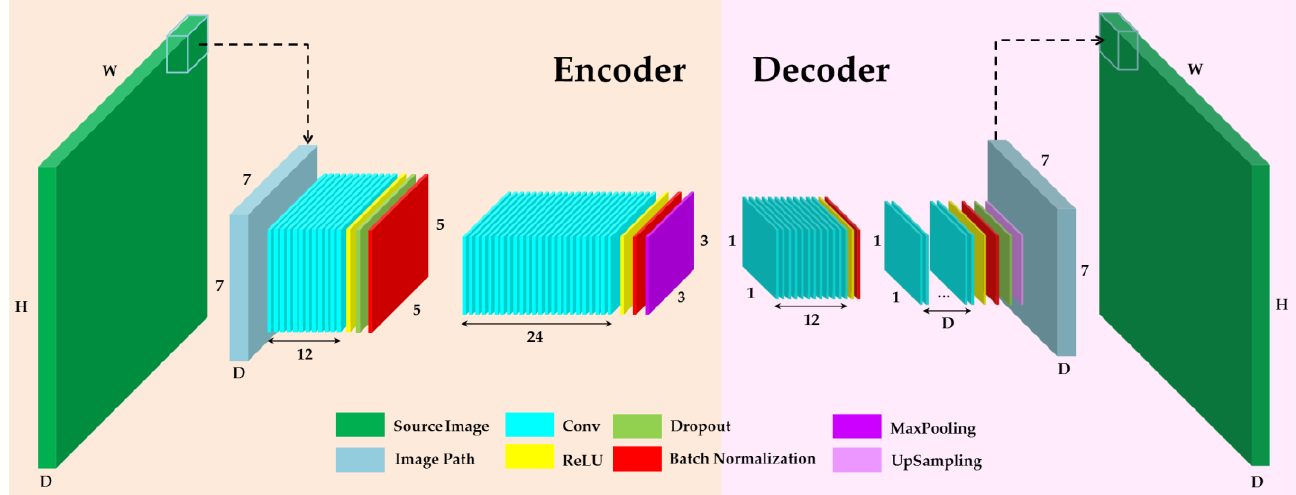
Figure 2. The proposed architecture of the CAE.